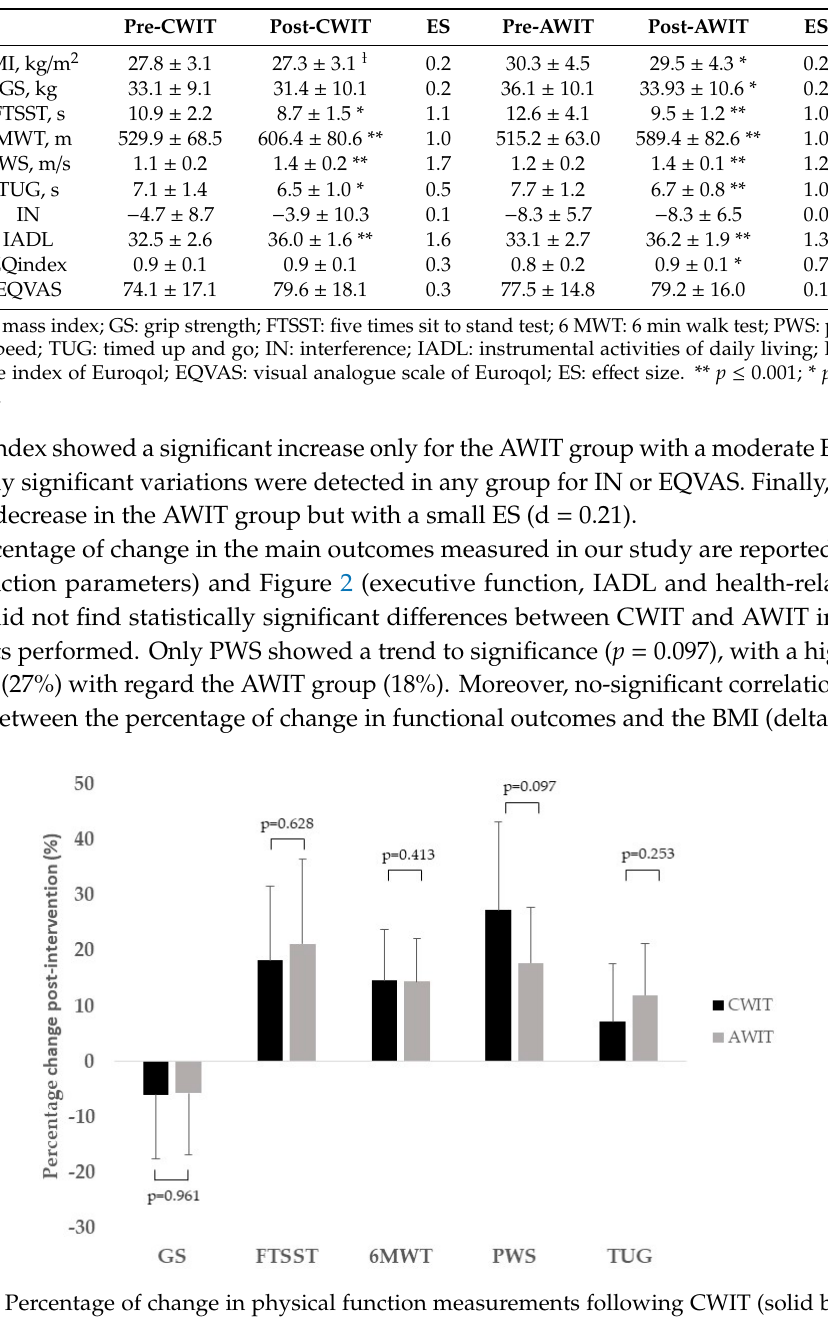
. Figure 2. Percentage of change in executive function, instrumental activities of daily living, and health-related quality of life measurements following CWIT (solid bar) and AWIT (gray bar). IN, inhibition; IADL, instrumental activities of daily living; CWIT, continuous walking interval training; AWIT, accumulated walking interval training. 4. Discussion